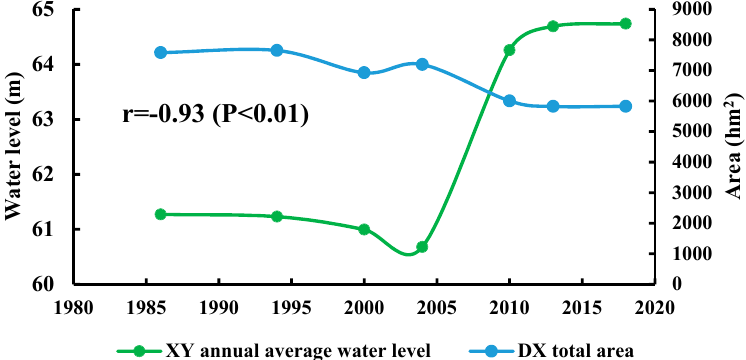
Figure 7. Changes in annual average of water level at Xiangyang station (XY) and total channel bar area in DX reach.